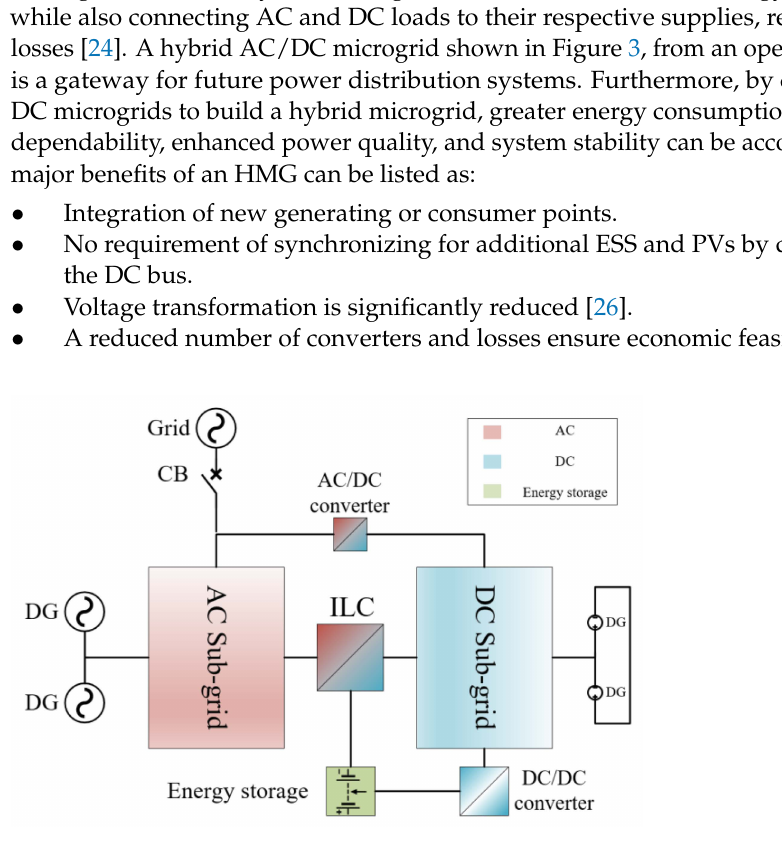
Figure 3. Layout of a hybrid